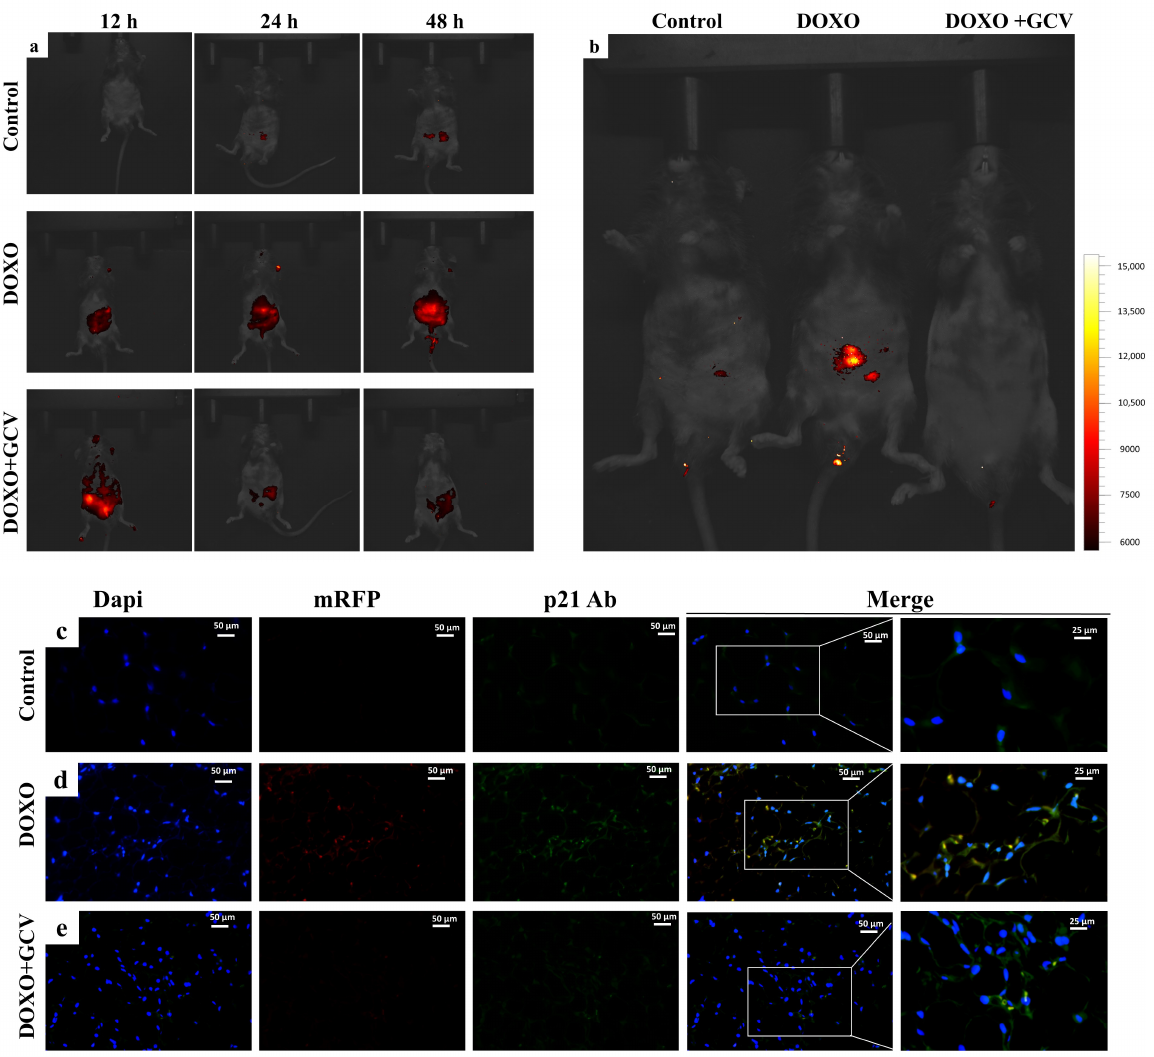
Figure 2. GCV treatment selectively kills p21 high cells in vivo. ( a , b ) Representative images of mRFP activity in the control/DOXO or DOXO+GCV treated groups. Mice were given 2 doses of DOXO (10 mg/kg) or PBS. GCV (15 mg/kg) was given immediately after DOXO treatment, a total of 5 doses. BLI was performed 12 h, 24 h, and 48 h after the administration. Experiments were repeated in 3 mice. ( c ) Representative micrographs of visceral fat sections from control/DOXO and DOXO+GCV group. Blue, dapi; red, mRFP; green, p21 ab(antibody). ( d , e ) P21 mRNA expression level of p21-3MR mice from control/DOXO and DOXO+GCV groups.